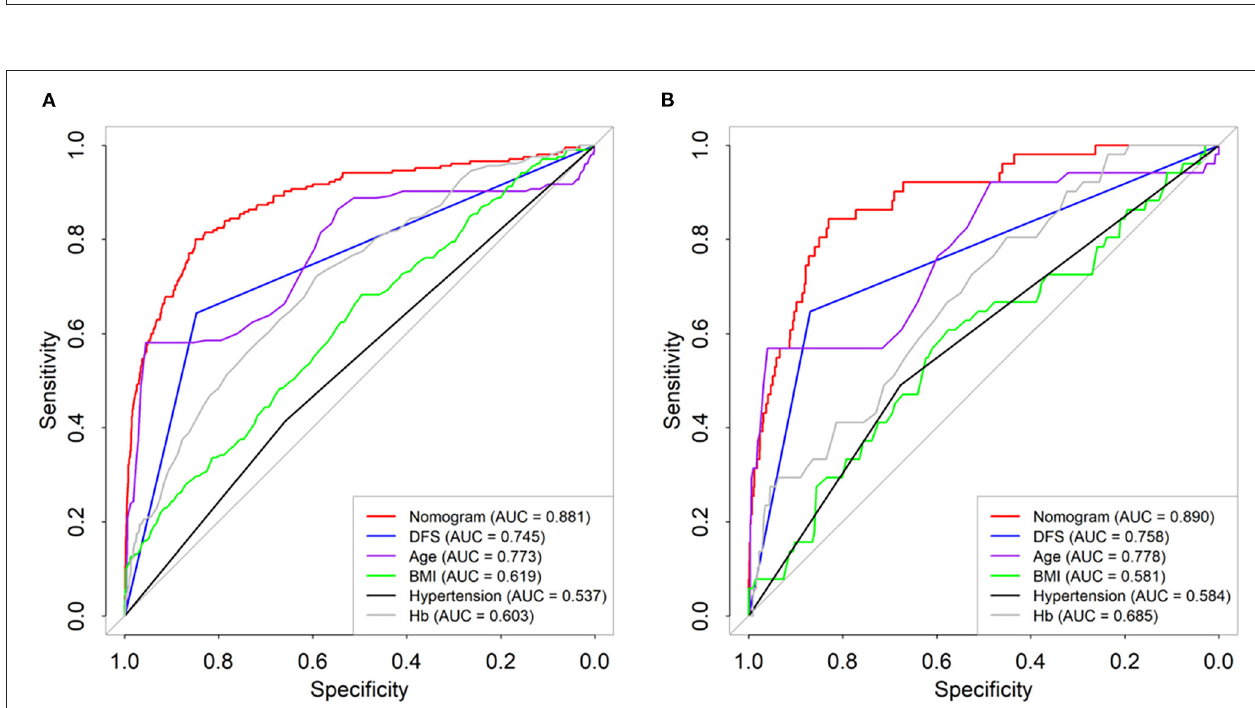
FIGURE 3 | Comparison of the predictive power of different indicators and nomogram plots for transfusion risk in training (A) and test datasets (B) .